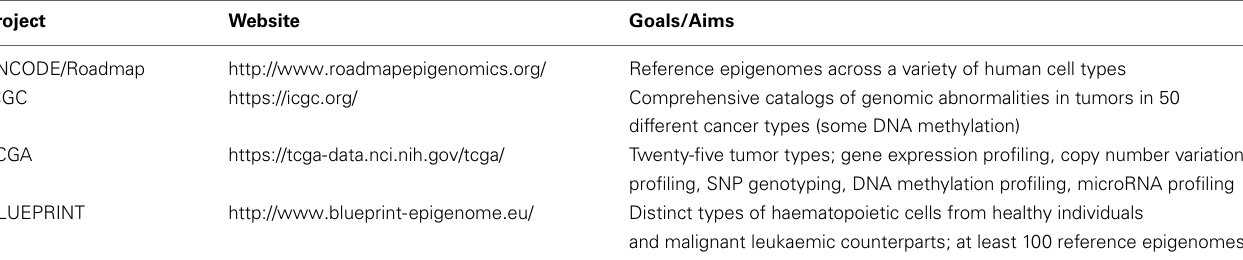
Table 1 | List of production science projects with significant DNA methylation data